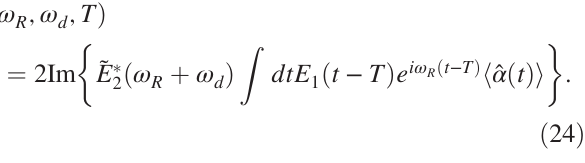
FIG. 7. CTRUECARS signal with a single coherent pulse. The signal [Eq. (23)] is exhibited for a pulse spectrum (a),(d) σ ¼ 0 . 5 eV ( 1 = σ ¼ 1 . 3 fs), (b),(e) σ ¼ 2 eV ( 1 = σ ¼ 0 . 33 fs), and (c),(f) σ ¼ 3 . 5 eV ( 1 = σ ¼ 0 . 19 fs). The signal is